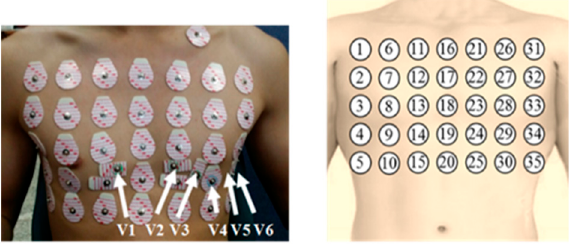
Figure 1. Locations and numberings of the electrodes on the subject’s chest.